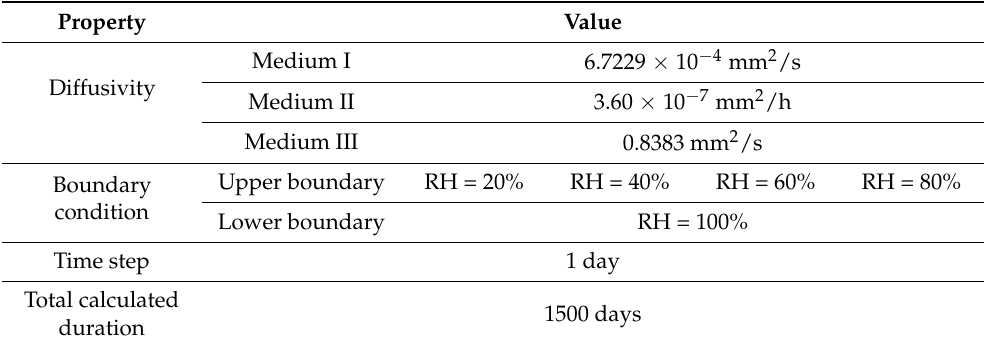
Table 12. The calculation parameters for the finite element model.